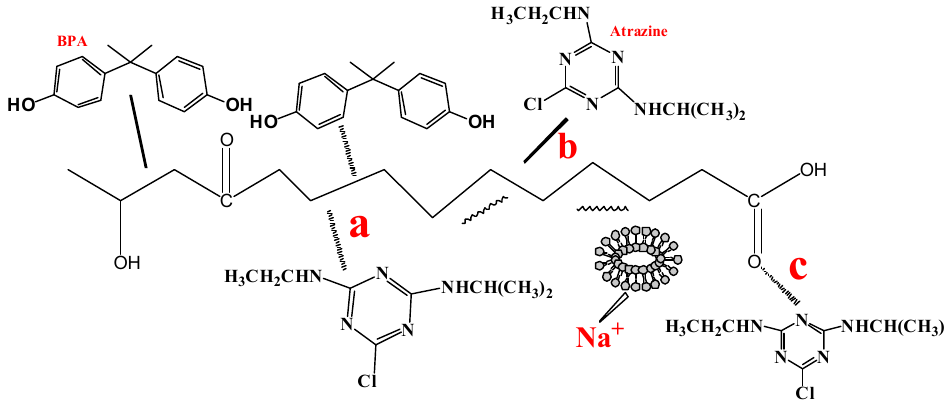
Figure 7. The adsorption mechanisms of atrazine for ACs onto samples in the presence of other substances (Notes: ( a ). π – π interactions; ( b ). Hydrophobic effect; ( c ). H-bond).